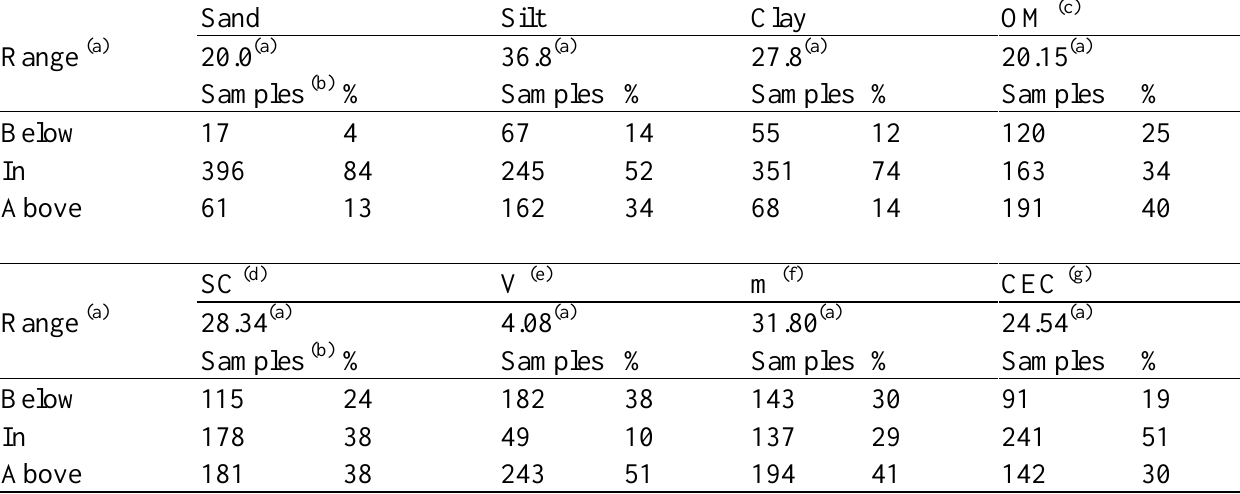
Table 3. Number of samples that used multiple regression equations to develop spectral models to determine soil attributes contents.